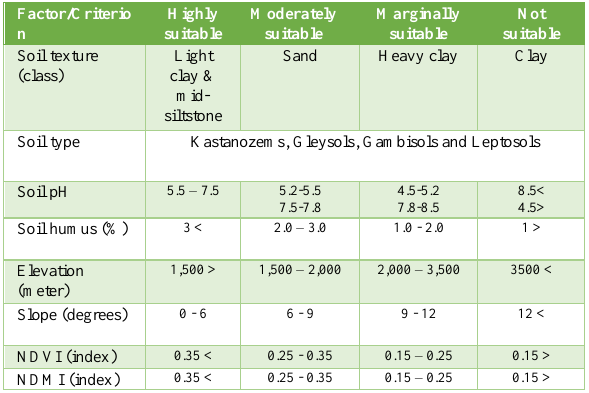
Table 3. Criteria for the cropland suitability based on the experts and the FAO (1984) for the structure in Bornuur soum